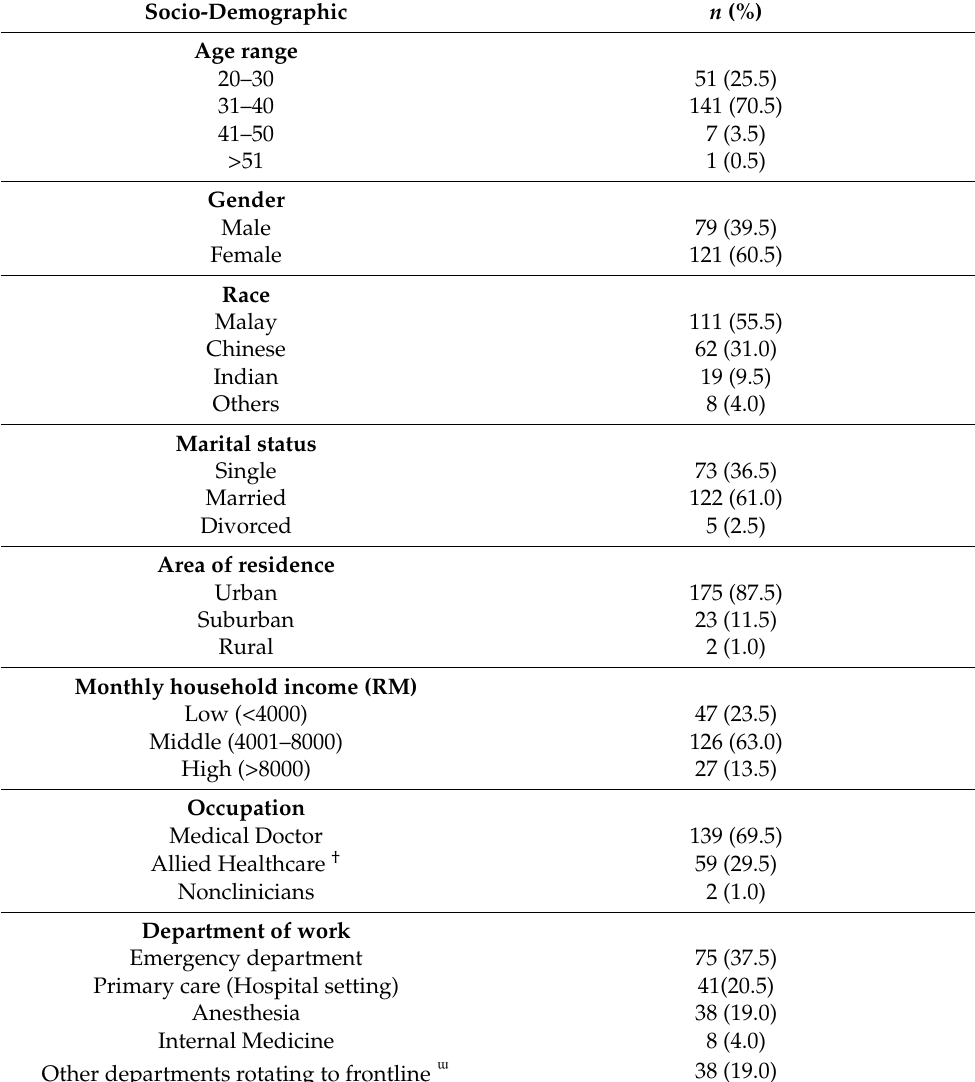
Table 1. Socio-demographic information of healthcare workers (HCWs) ( n =